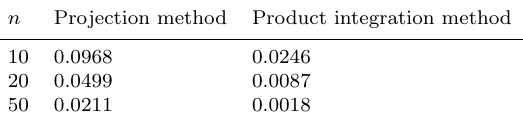
Table 1. Relative